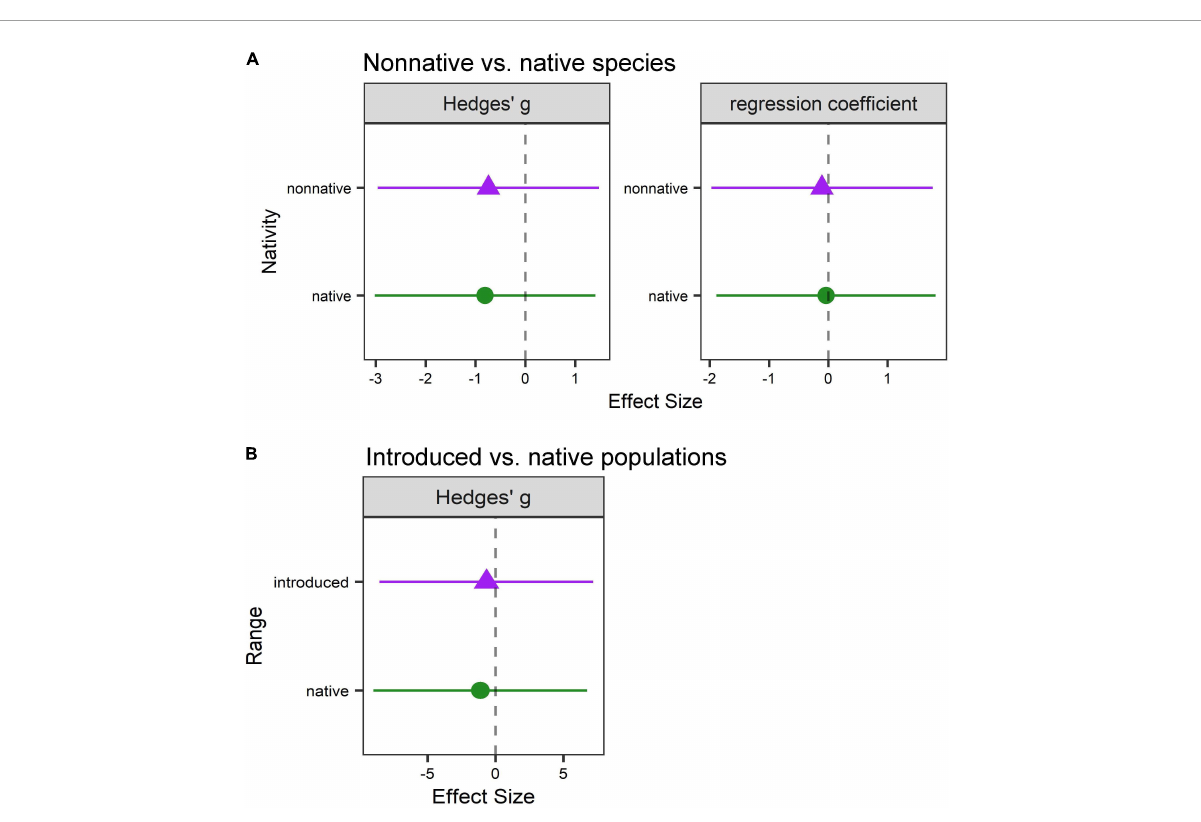
FIGURE4 Phenological sensitivity to climate does not differ between (A) non-native vs. native plant species or (B) introduced vs. native populations of non-native plant species. Native species/populations are shown as green circles; non-native species/introduced populations are shown as purple triangles. Values are (left) mean effect sizes (Hedges’ g ) or (right) regression coefficients and 95% confidence intervals estimated from mixed-effect meta-analysis models. Negative values indicate that the timing of a phenophase was earlier under climate change (warmer and/or drier) conditions relative to ambient conditions (the dashed line indicates zero, or no